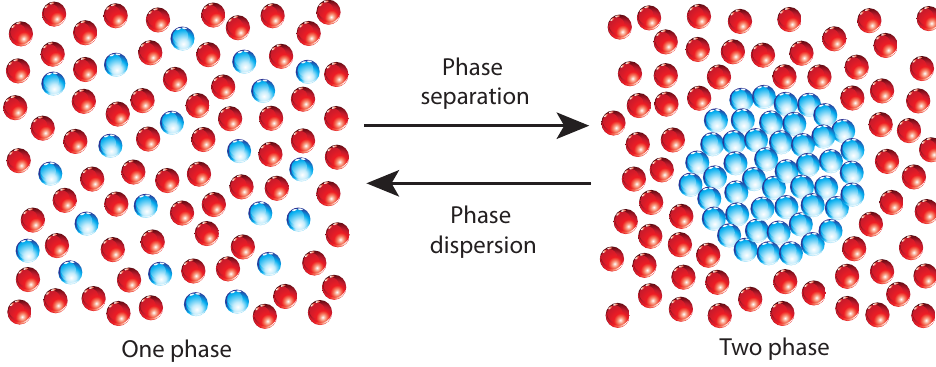
Figure 1. To the left , a biological fluid in a dispersed state is depicted. The fluid behaves as an ideal liquid. To the right , the same fluid in a liquid–liquid phase separation is depicted. The phase in blue is highly compressible. The other phase in red is highly